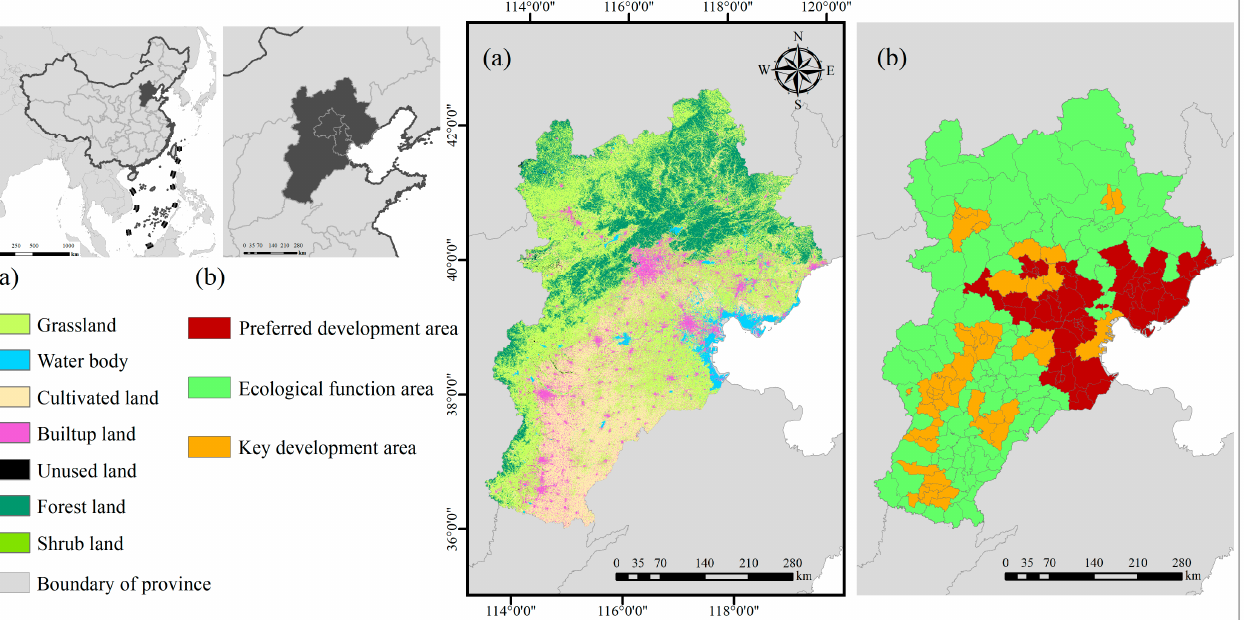
Figure 2. Study area. ( a ) LULC distribution of cover types. ( b ) Map of major function-oriented areas, including preferred development area (PDA), ecological function area (EFA), and key development area (KDA).